Question: Does the plotted quantity increase or decrease?
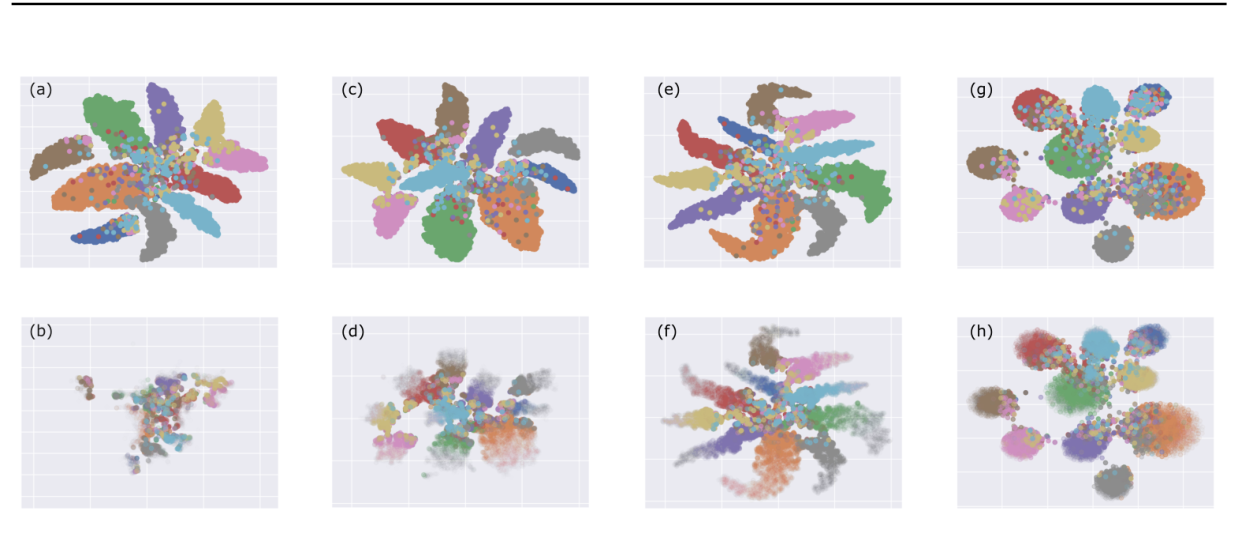
Answer: increasing